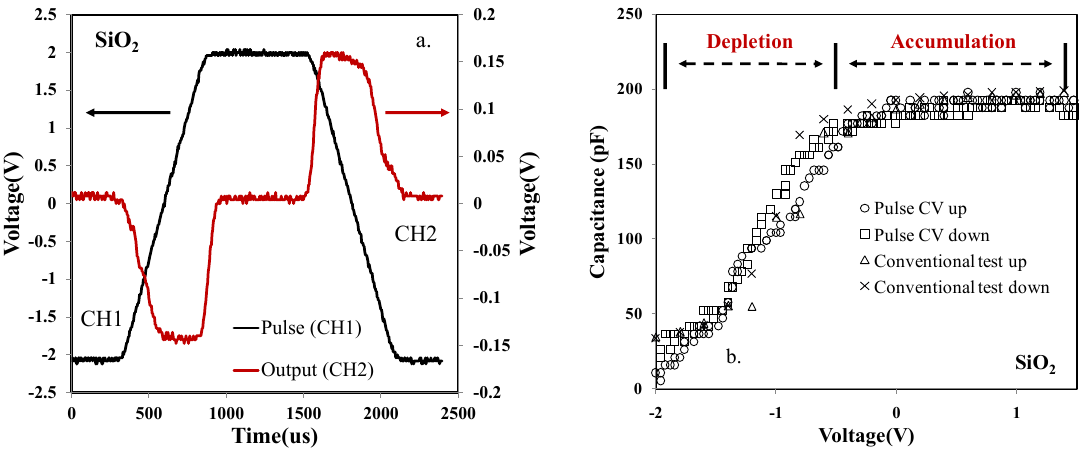
Figure 4. ( a ) Voltage (V) versus time (μs) of a thermal SiO 2 MOS sample. ( b ) Capacitance (pF) versus voltage (V) of the SiO 2 MOS